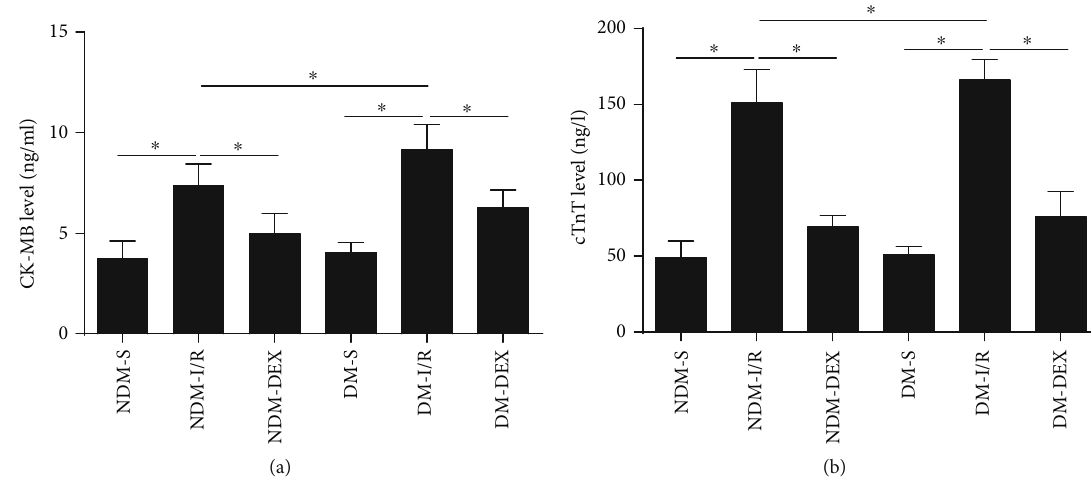
Figure 1: DEX reduces serum CK-MB and cTnT levels in rats. CK-MB and cTnT levels in rat serum were detected by ELISA. (a) CK-MB level. (b) cTnT level. All results are expressed as the mean ± SD . ∗ P < 0 : 05 between each